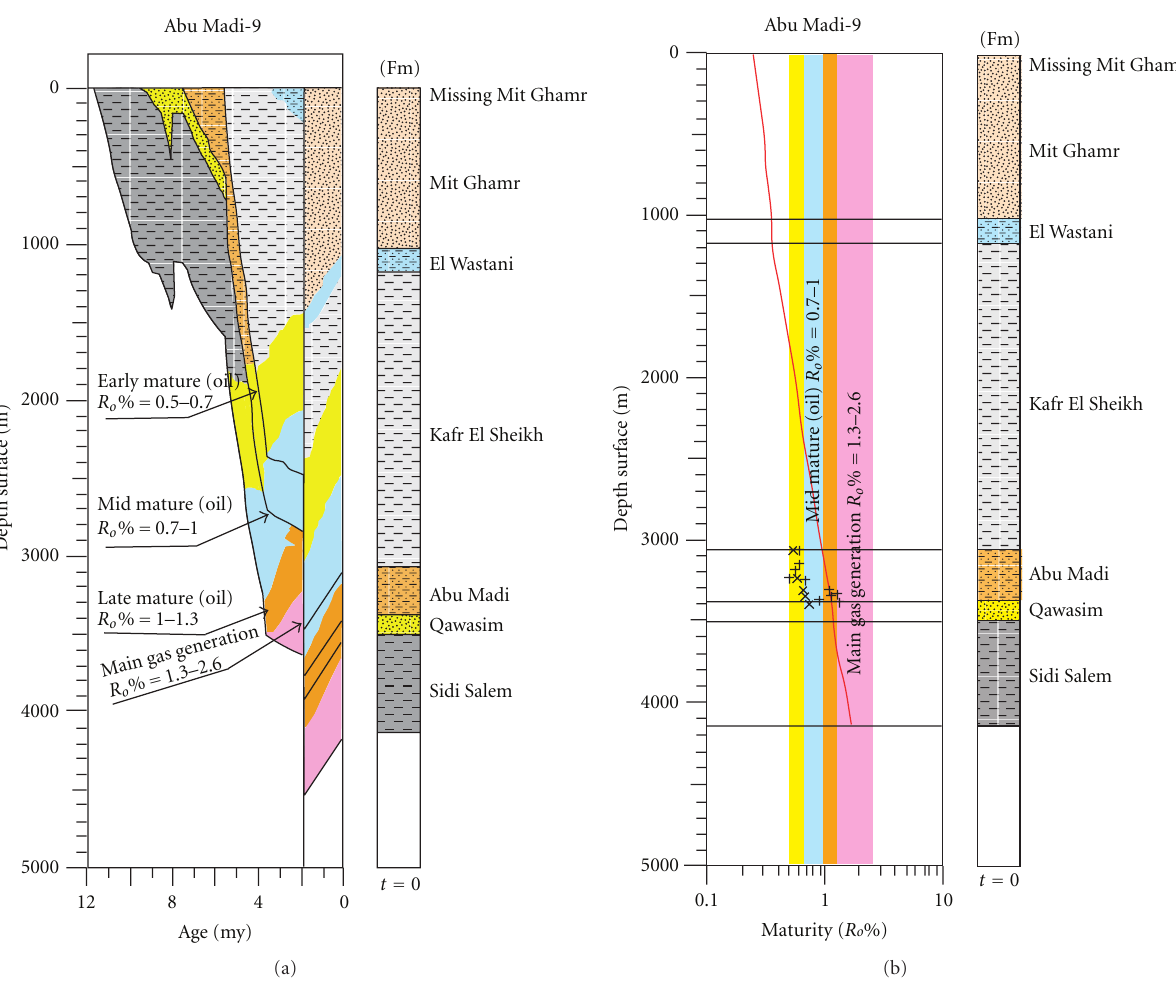
Figure 6: (a) Burial history curve for Abu Madi-9 well showing the calculated maturity (b) the measured maturity for samples taken from Abu Madi formation. Both figures agree the level of maturity for Abu Madi formation (early to mid